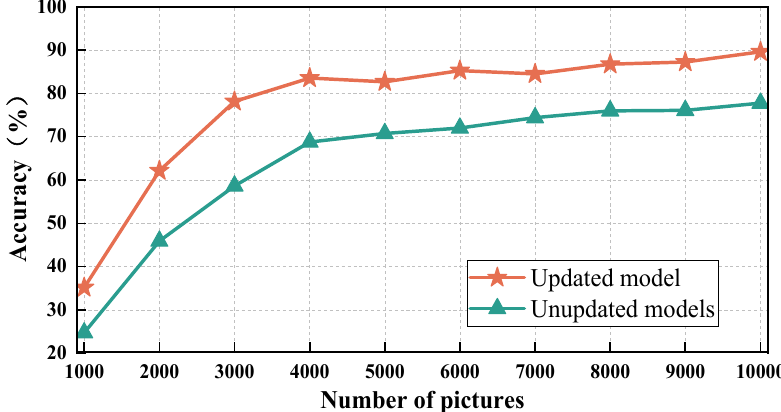
Figure 10. Accuracy of updated and un-updated models.